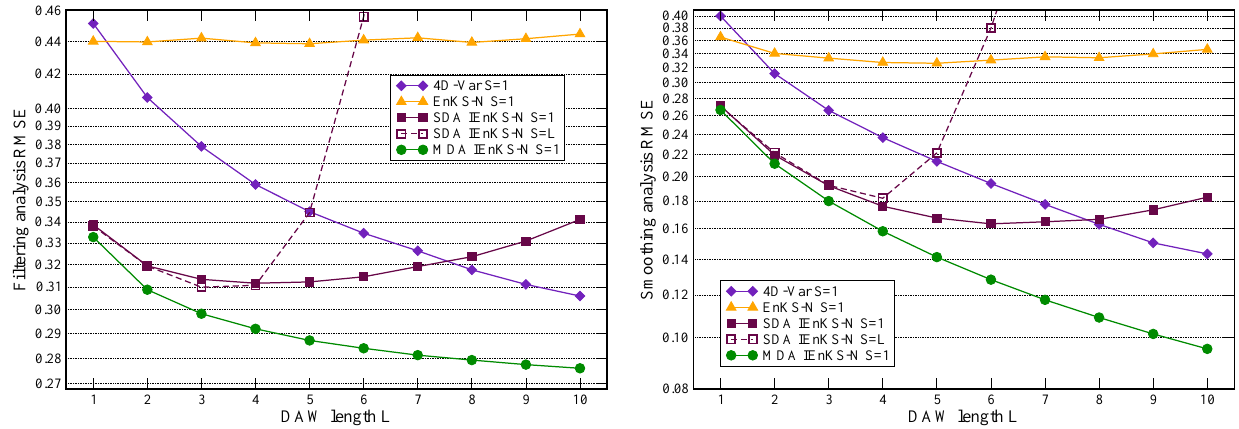
Fig. 3. Comparison of the filtering (left) and smoothing (right) performance of the SDA IEnKS, MDA IEnKS, the EnKS and 4D-Var, in weakly non-linear conditions corresponding to ∆ t = 0 . 05 .